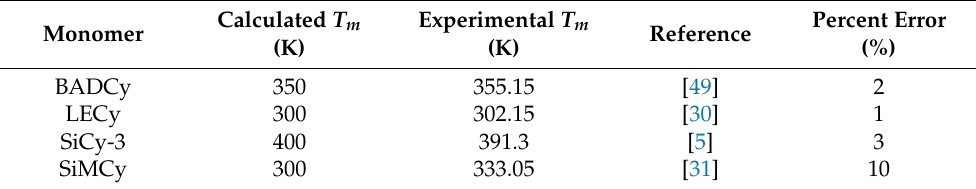
Figure 5. The evolution of volume as a function of temperature for SiMCy with: ( a ) 256 and ( b ) 400 molecules. Table 1. The melting points of cyanate ester monomers with 9% voids compared to previously reported literature